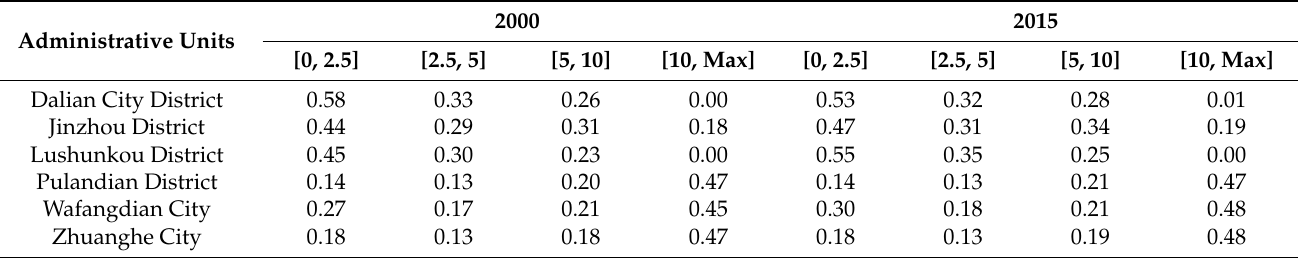
Table 10. Changes in the balance of the land use structure of the administrative units in